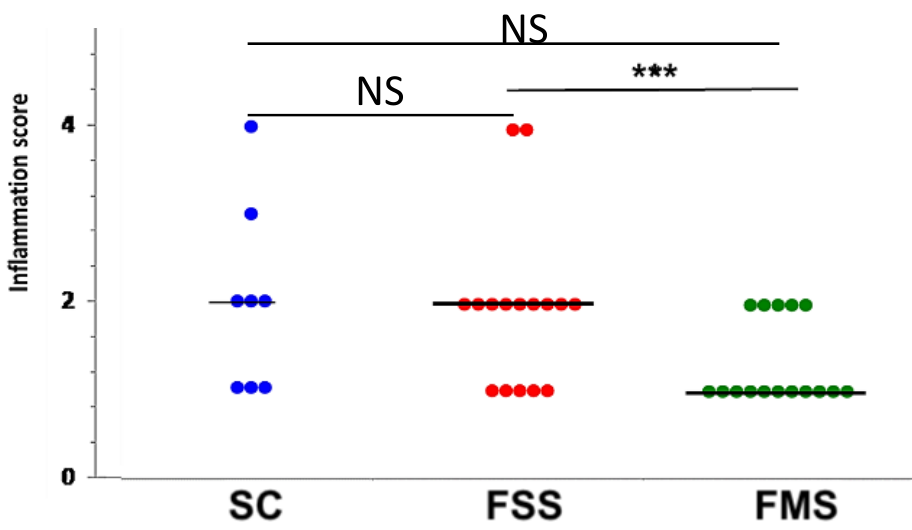
Figure 3. Spread plot of inflammation (colitis) scores for each group of mice at necropsy, at day 10. Horizontal lines at the median. Differences tested by one-way ANOVA (overall p = 0.06) followed by multiple comparisons Dunn’s test (*** p < 0.001). (NS non-significant). There was no difference in faecal iron concentration between the three experimental groups at baseline (day 1). At day 10 there was a significant increase in faecal iron compared Figure 3: Spread plot of inflammation (colitis) scores for each to baseline in the mice receiving the FSS diet; the change with FMS was not statistically group of mice at necropsy, at day 10. Horizontal lines at the significant. This is consistent with the greater severity of colitis in mice receiving the FSS median. Differences tested by one-way ANOVA (overall p=0.06) diet (Figure 4). followed by multiple comparisons Dunn’s test (***P<0.001). [NS